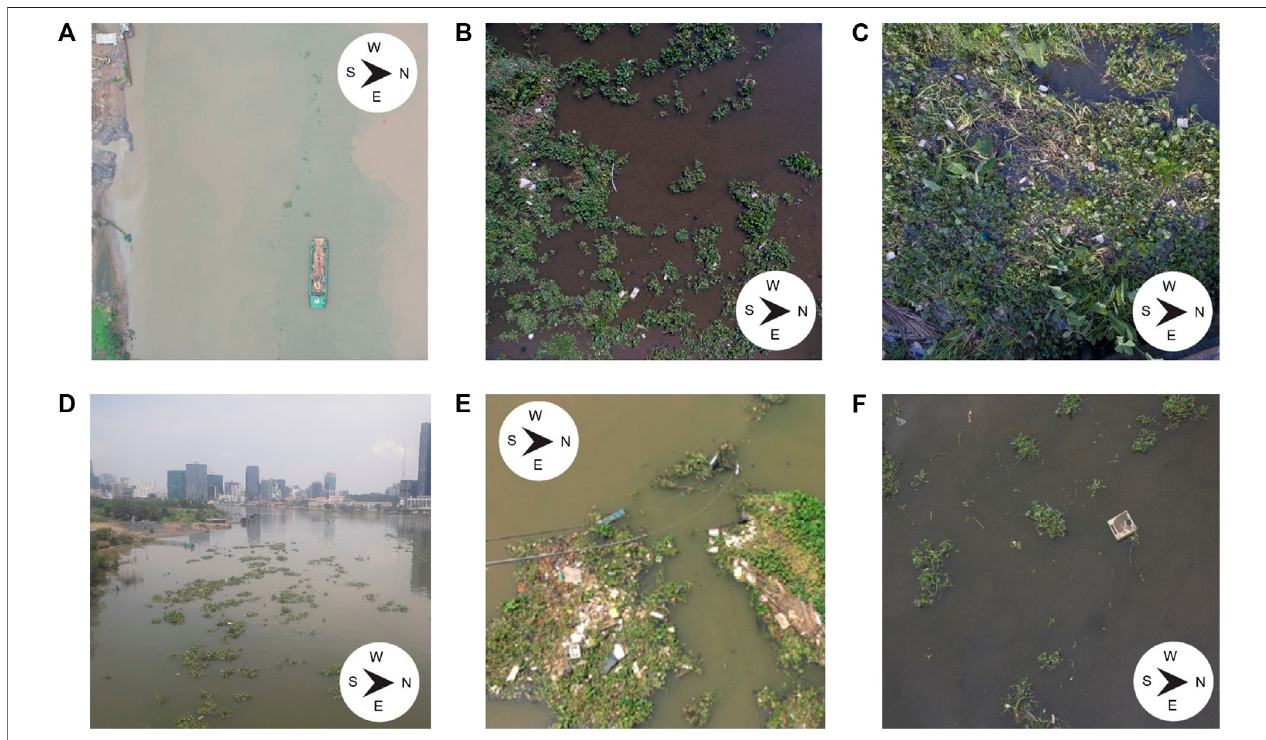
FIGURE 1 | Photographs taken at Ho Chi Minh City, Vietnam. The upper fi gures show the UAV images taken at different altitudes. The lower fi gures show photographs taken from bridges, facing the river downstream, at approximately 15 m of altitude. (A) UAV image taken at approximately 60 m, showing the southern cross-sectionoftheriver.Patchesofhyacinthsarevisibleafewmetersdownstream(West)fromtheboat (B) PatchesofdifferentsizesclearlyvisiblefromtheUAVimage at an altitude of approximately 10 m. (C) A patch of water hyacinths visible from an altitude of less than 10 m. Plastic items are clearly visible. (D) Overview of the Saigon river. Large water hyacinths patches are visible on the forefront. (E) Large water hyacinths patches, many entangled plastic items are visible. (F) Individual water hyacinths, not aggregated in large patches and a free- fl oating debris.